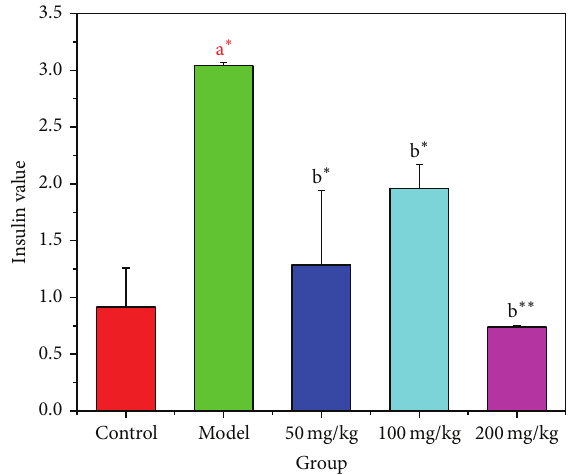
Figure 3: The effect of HuSang 32 branch bark extract on diabetic mice insulin level. A ∗ , compared with normal control group, 𝑃 < 0.05 , significant difference; b ∗ compared with model group, 𝑃 < 0.05 , significant difference; b ∗∗ , compared with model group, 𝑃 < 0.01 , very